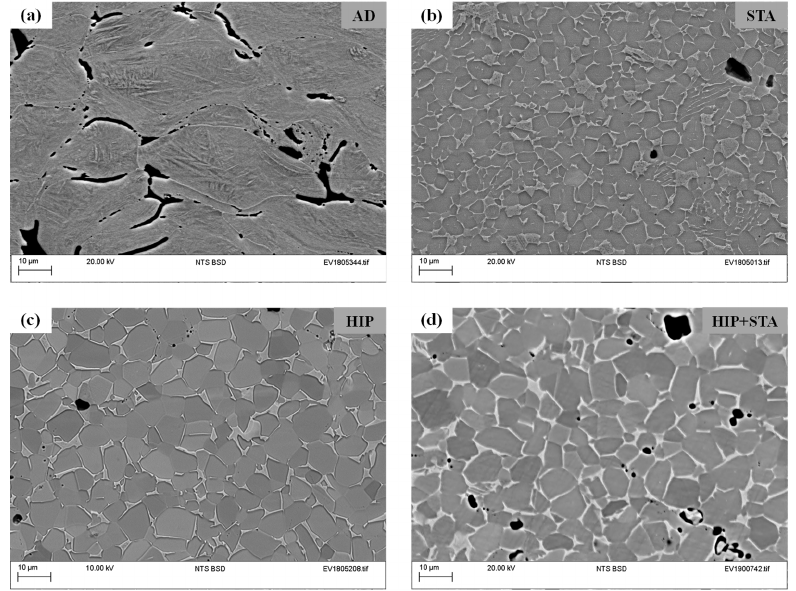
Figure 2. Cross-sectional SEM images of CS Ti6Al4V material for four conditions: ( a ) AD, ( b ) STA, ( c ) HIP, ( d ) HIP + STA.